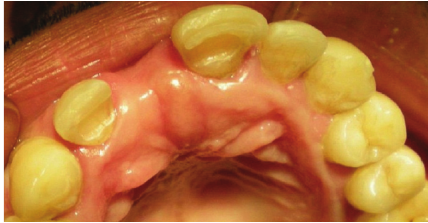
Figure 3: Slots prepared at palatal surface of abutments.